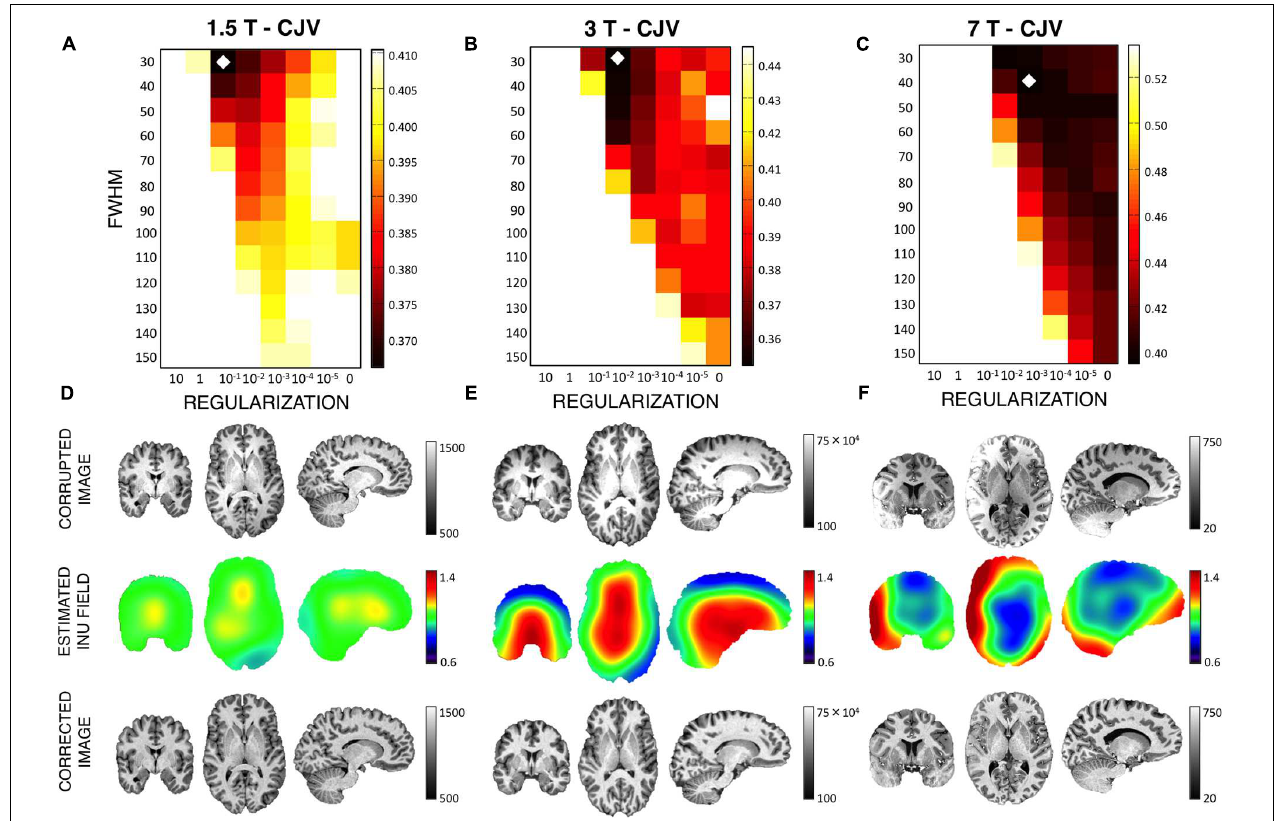
FIGURE 8 | Intensity non-uniformity correction on actual MR images. We examined the effectiveness of the CJV analysis on actual MR data, after smoothing, and mask optimizations, for three representative images collected using a 1.5 T, a 3 T, and a 7T MR scanner (A–C) , respectively. The diamond marker highlights the input parameter configuration selected on the basis of the CJV results. INU-corrupted image, estimated INU field and INU-corrected image are shown for each dataset (D–F)